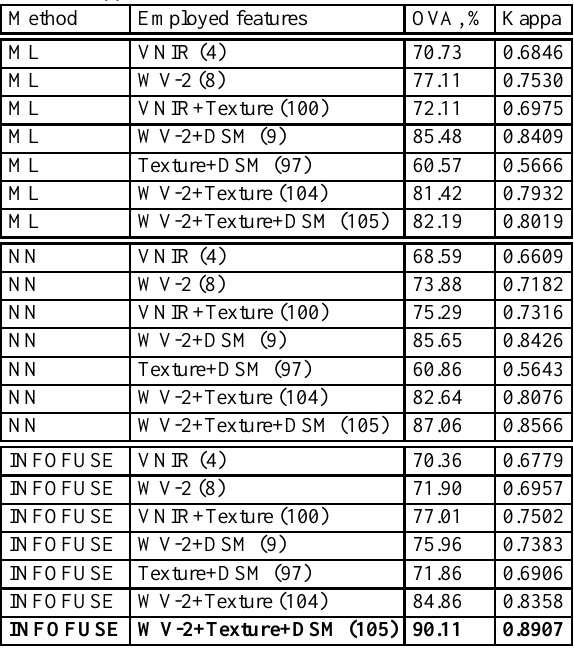
Table 2: Classification accuracy using different methods together with the proposed approach. OVA – overall accuracy, Kappa – Kohen’s Kappa. Best result is marked in bold